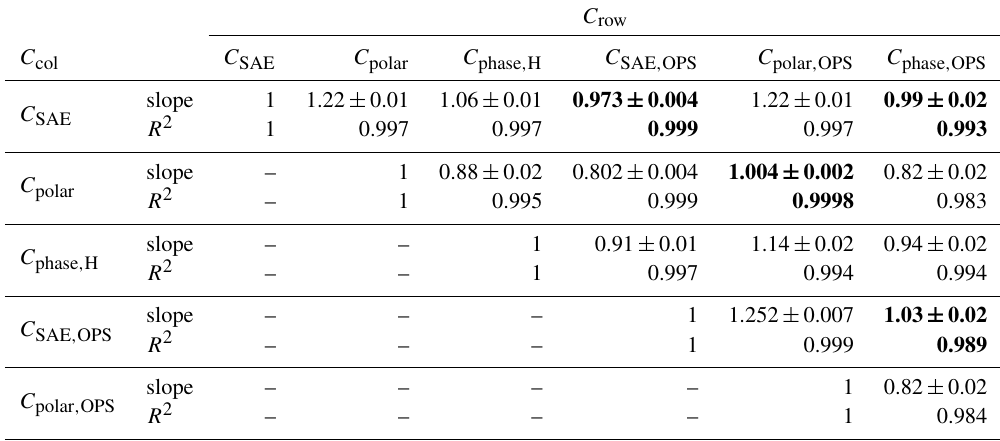
Table 6. Polydisperse aerosol: mineral dust, silica dust, and volcanic ash. Results of the regression analysis ( C rows = slope · C columns and coefficient of determination R 2 ) of each angular correction reported in the table rows C rows vs. each angular correction reported in the table columns C columns . Results within ± 3% are highlighted in